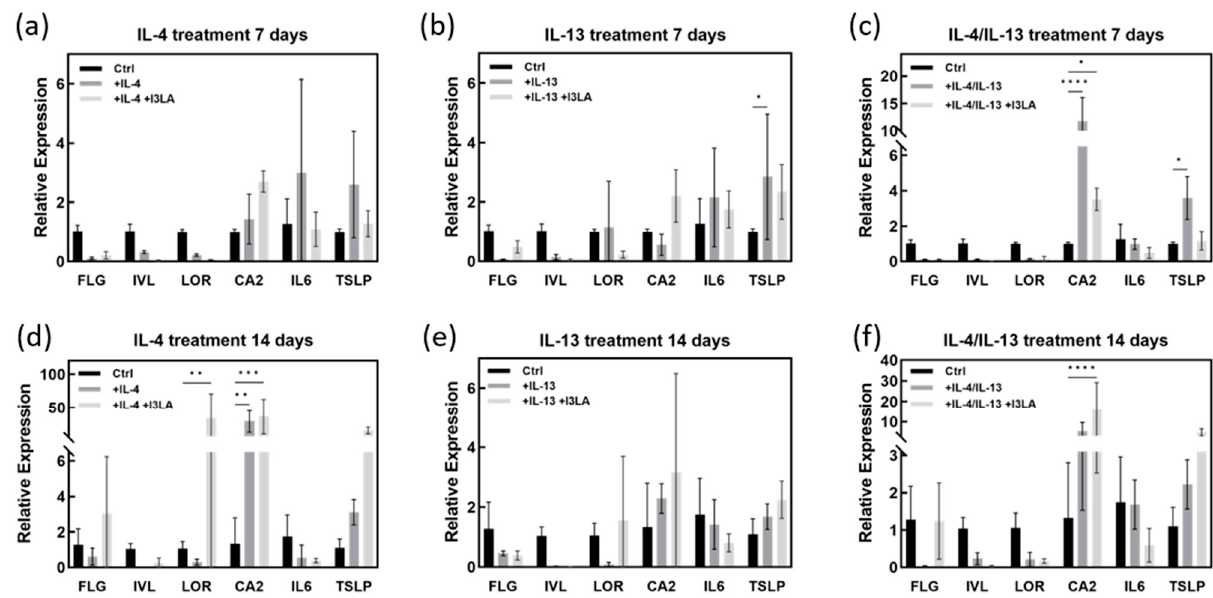
Figure 3. Processed real-time PCR results of I3LA treatment in AD-HSEs stimulated with IL-4 and/or IL-13. Gene expression results for AD-HSEs treated with IL-4 and IL-13 at different concentrations and for different time periods, the control group, and the group treated with I3LA. ( a ) Group treated with IL-4 for 7 days, ( b ) group treated with IL-13 alone for 7 days, ( c ) group treated with combined IL-4 and IL-13 for 7 days, ( d ) group treated with IL-4 alone for 14 days, and ( e ) group treated with IL-13 alone for 14 days. ( f ) FLG, IVL, LOR, CA2, IL-6, and TSLP gene expression comparison graphs in the group treated with combined IL-4 and IL-13 for 14 days ( n = 3; two-way ANOVA; Dunnett’s comparisons t test; * p < 0.05; ** p < 0.01; *** p < 0.001; **** p < 0.0001).